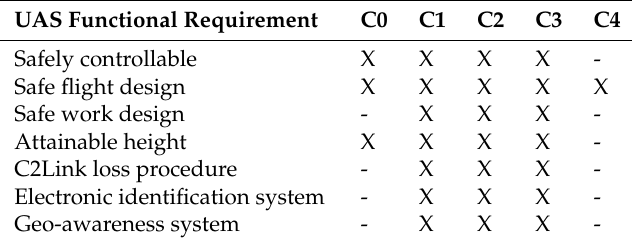
Table 9. UAS functional characteristics requirements excerpt [6].